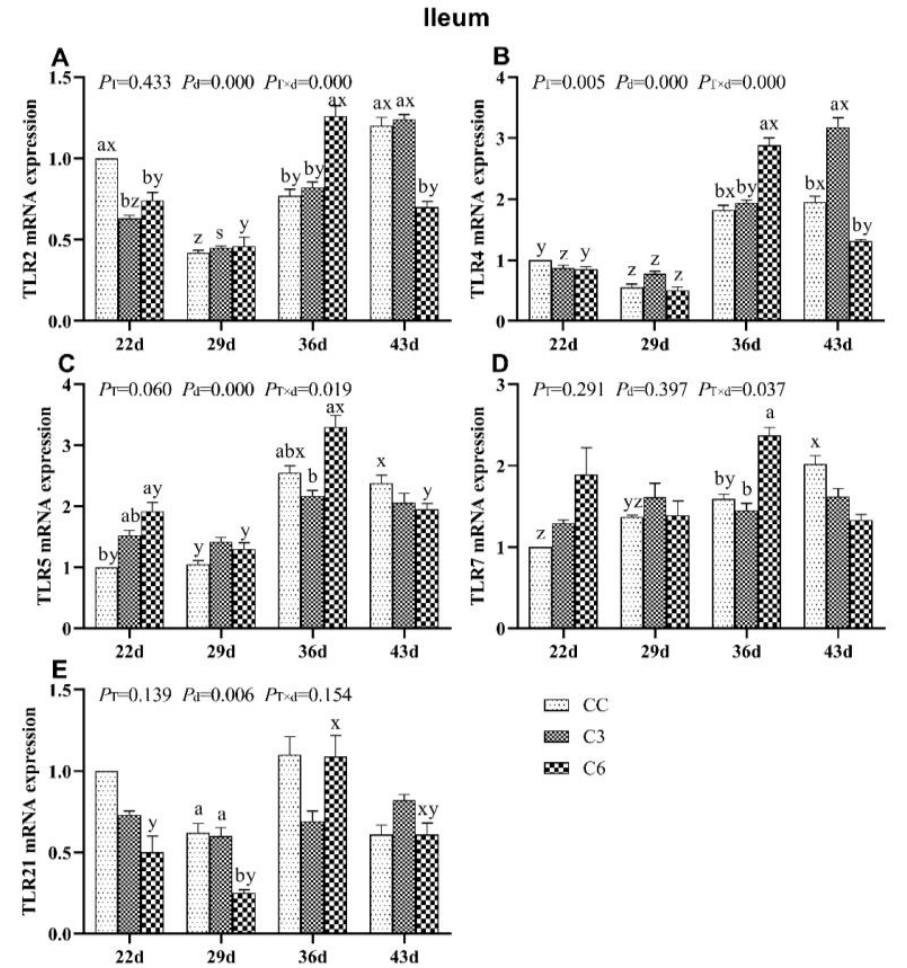
Figure 8. mRNA levels of Toll-like receptors TLR2 ( A ), TLR4 ( B ), TLR5 ( C ), TLR7 ( D ), and TLR21 ( E ) in the ileum of broilers. Different letters indicate significant differences ( p < 0.05) between treatment groups (a, b) and days of age (x, y, z, s).